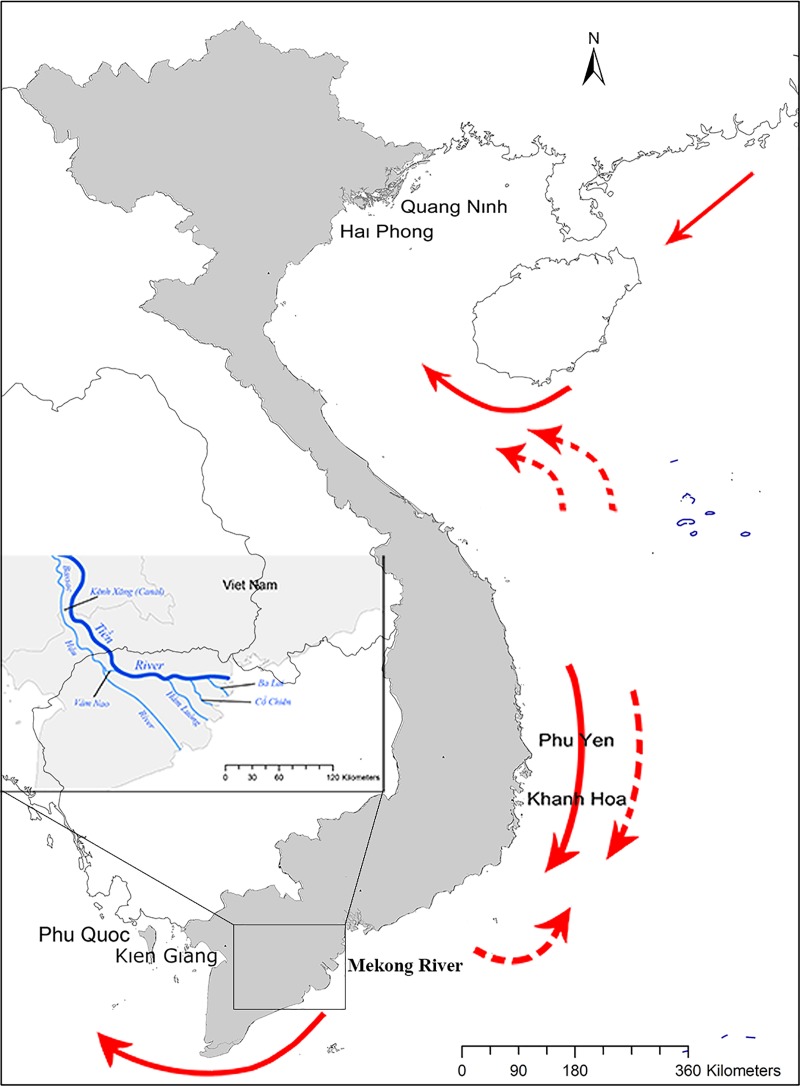
Sampling map of Portunus pelagicus and surface currents following northeast (bold line) and southwest (dash line) monsoons, INSET: Mekong River (black box) in Mekong delta, Vietnam.